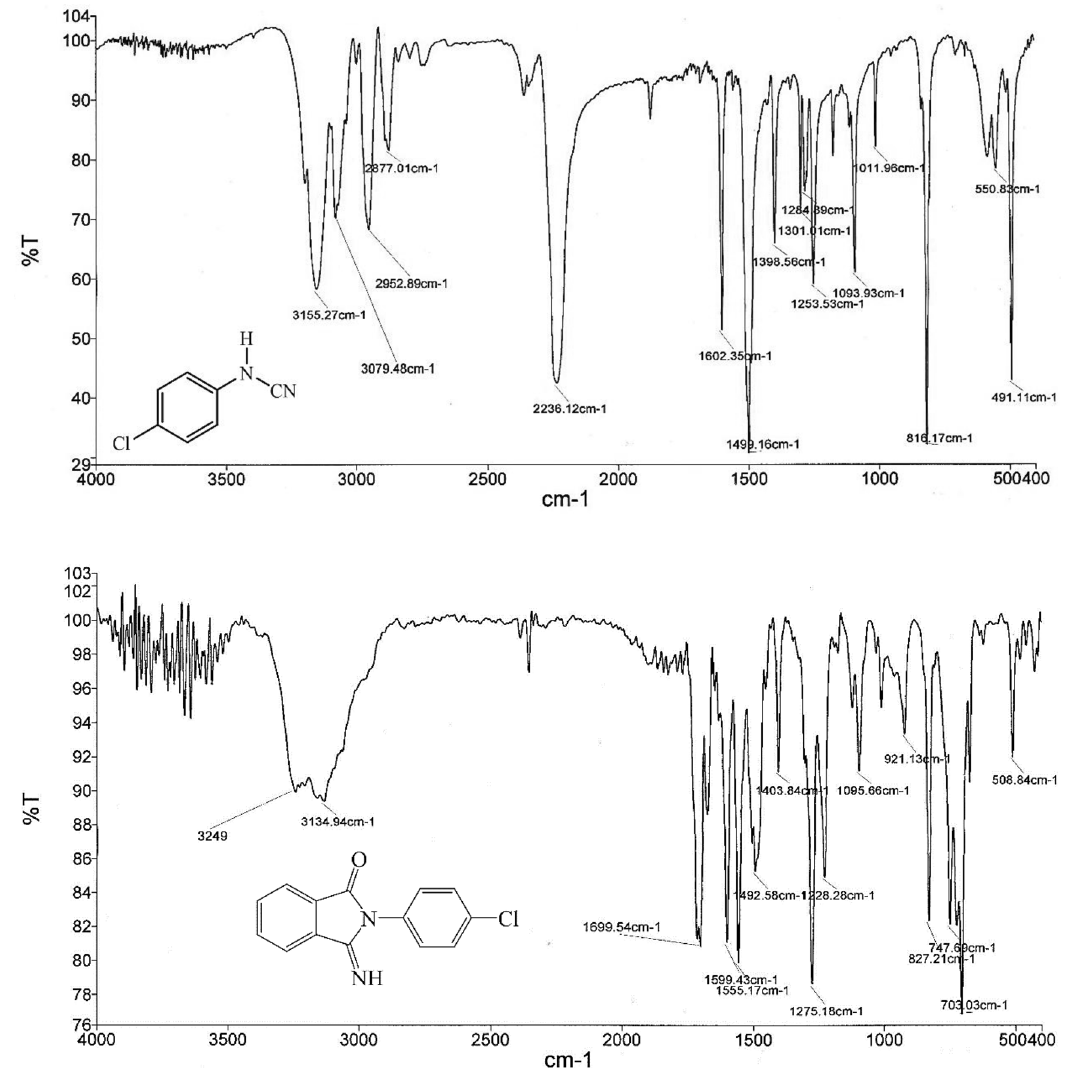
Figure 8. FT-IR spectra of N -(4-chlorophenyl)cyanamide (top) and 2-(4-chlorophenyl)-3-iminoisoindolin-1- one